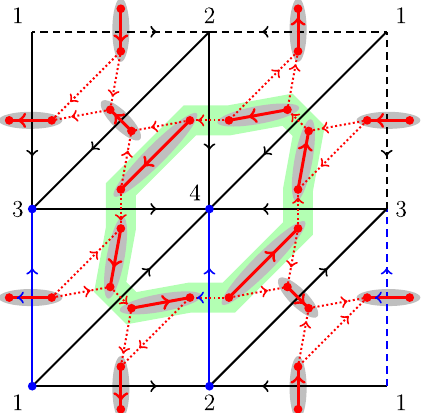
FIG. 4. Example of triangulation T of torus and Kitaev chain decoration. All vertices h 1 i , h 2 i , h 3 i , and h 4 i (blue dots) are singular vertices; i.e., w 0 ¼ h 1 i þ h 2 i þ h 3 i þ h 4 i . We choose link h 13 i and h 24 i (blue lines) to be singular lines; i.e., w 0 ¼ ∂ ðh 13 i þ h 24 iÞ . The direction of the red links dual to h 13 i and h 24 i are changed. Vertices i ¼ 1 , 2, 3, and 4 of T are ∈ G . Majorana fermions (red dots) labeled by group elements g i ˜ P reside on the vertices of the resolved dual lattice (solid and dashed red links). The solid red links and gray ellipses indicate that the two Majorana fermions at their two ends are paired with respect to the link direction. The green strip is the Z 2 domain wall of the “ spin ” configuration f g and is decorated by a Kitaev ’ s i g Majorana chain (Majorana fermions along the domain wall are paired differently from the “ vacuum ”